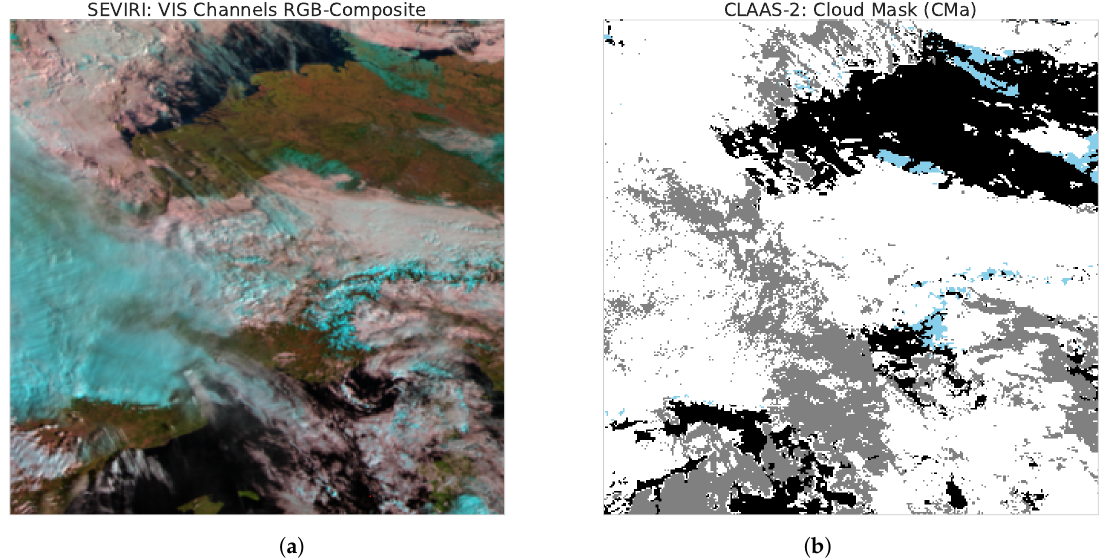
Figure 1. An RGB-composite created from SEVIRI Channels 1–3 ( a ) and the corresponding CLAAS-2 cloud mask ( b ) for the study area used in this study. The displayed date is 22 February 2011 09:00:00 UTC. Cloud-free = black, cloud-contaminated = gray, cloud-covered = white, snow/ice =